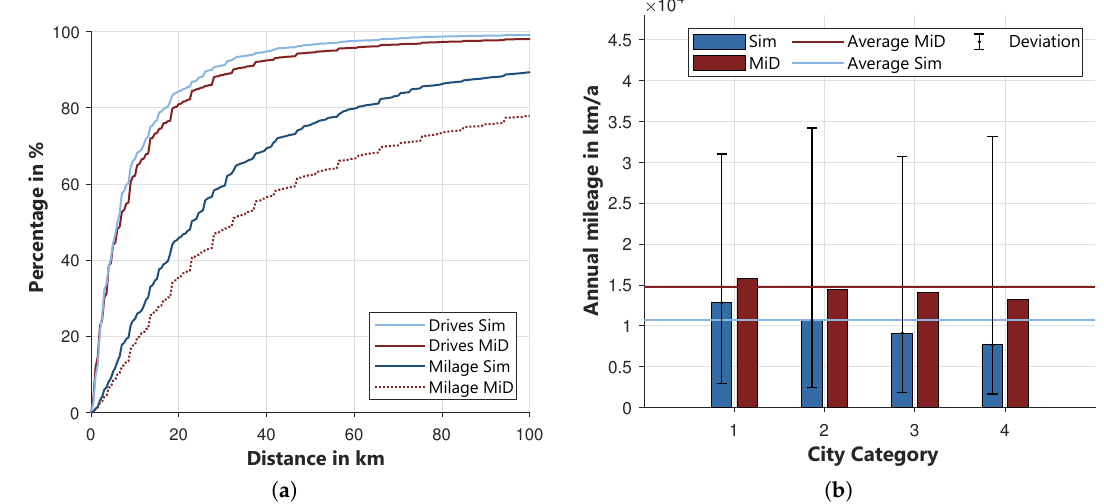
Figure 14. ( a ): Cumulative percentage of drives and kilometrage depending on the distance, ( b ): Annual kilometrage of the simulated cars compared to the